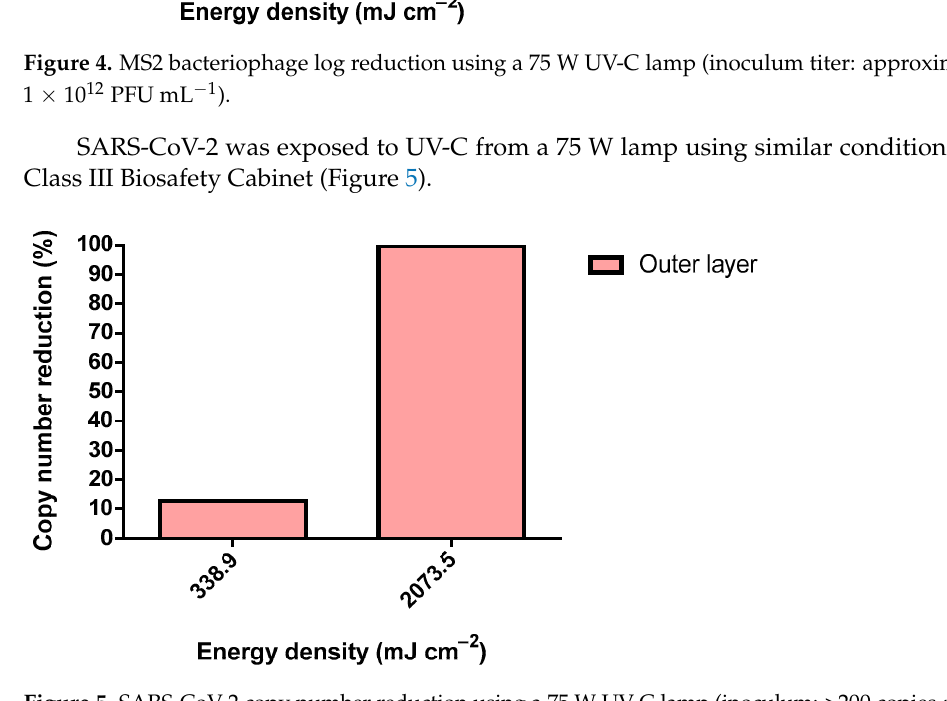
Figure 5. SARS-CoV-2 copy number reduction using a 75 W UV-C lamp (inoculum: >200 copies μ L − 1 ).